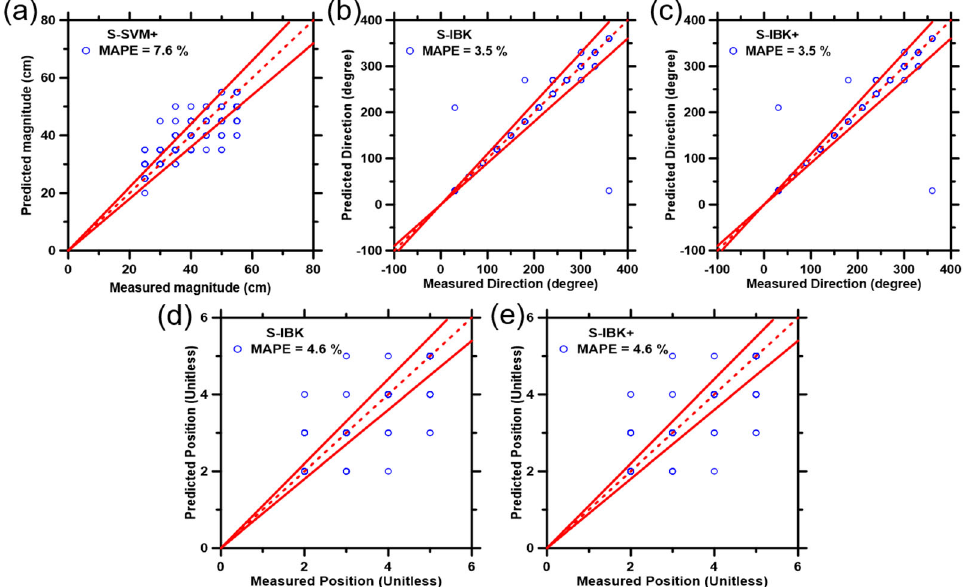
Figure 7. Best results of the predicted data points (25% database) versus the measured data points (75% database) on the ( a ) impact magnitude, ( b , c ) direction, ( d , e ) latitude, using the boosted ML models that include: (1) SVM+, (2) S-SVM, (3) S-SVM+, (4) IBK+, (5) S-IBK, and (6) S-IBK+. The plotted data represent 25% of the parent database that was not previously included in the training process of the ML models. The dashed line represents the line of ideality, and the solid lines represent ±10% boundaries.